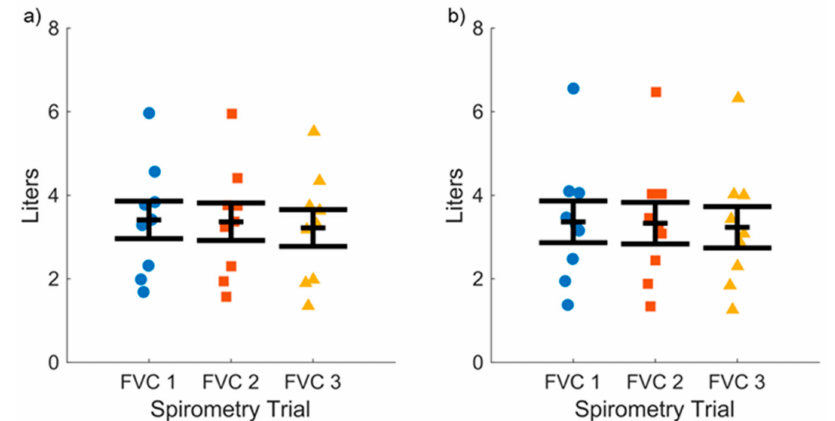
Figure 4. Forced vital capacity (FVC) values measured across three consecutive vital capacity maneuvers for asthma subjects for: ( a ) Our open access modular spirometer; and ( b ) the traditional commercial spirometer. Mean ± SEM values for the novel and traditional spirometer are shown.